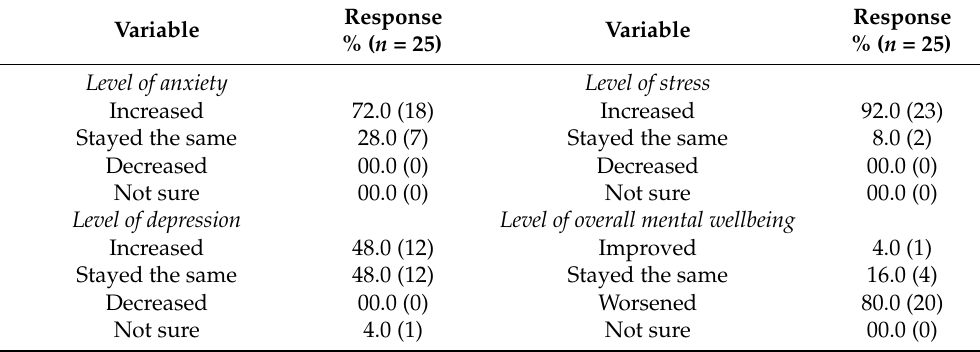
Table 3. Self-reported perceived change in mental health of participants from before the pandemic compared to the